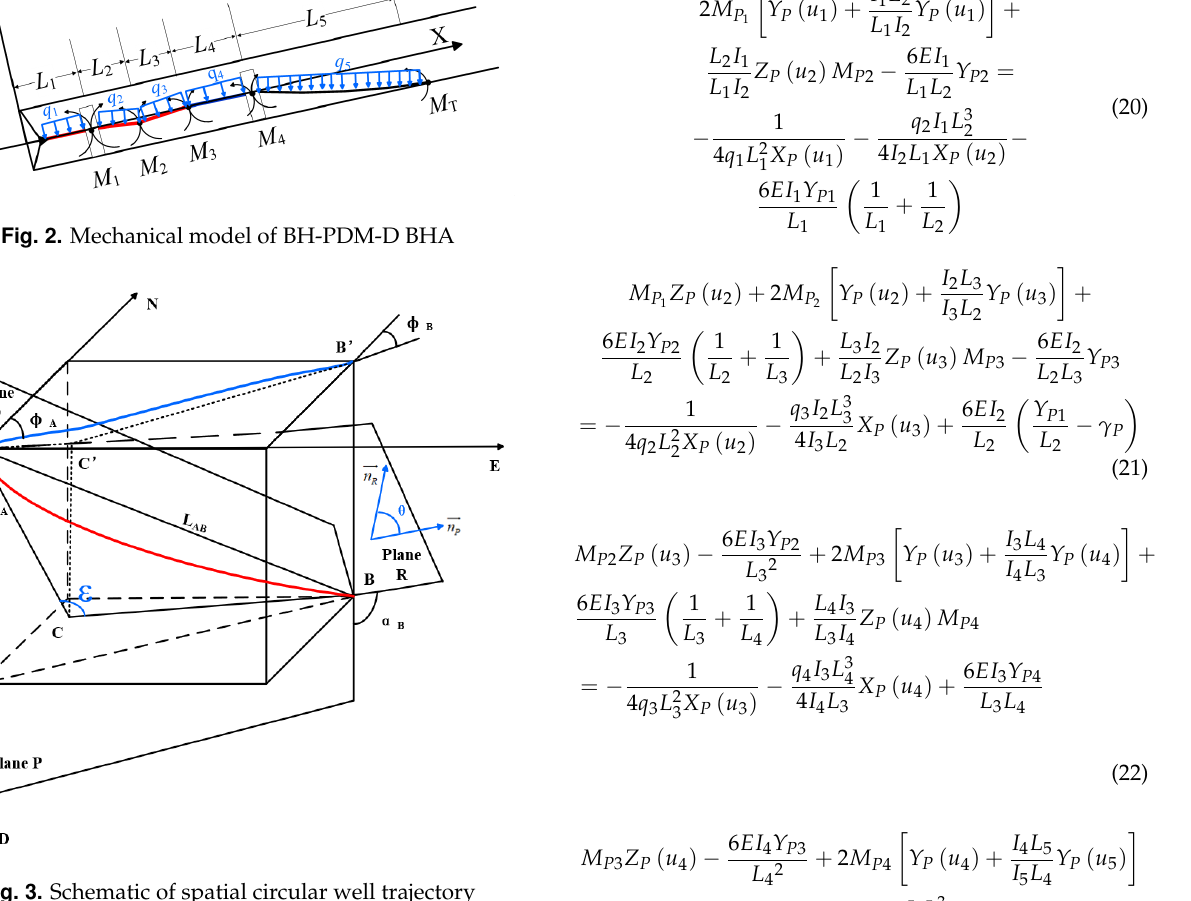
Fig. 3. Schematic of spatial circular well trajectory